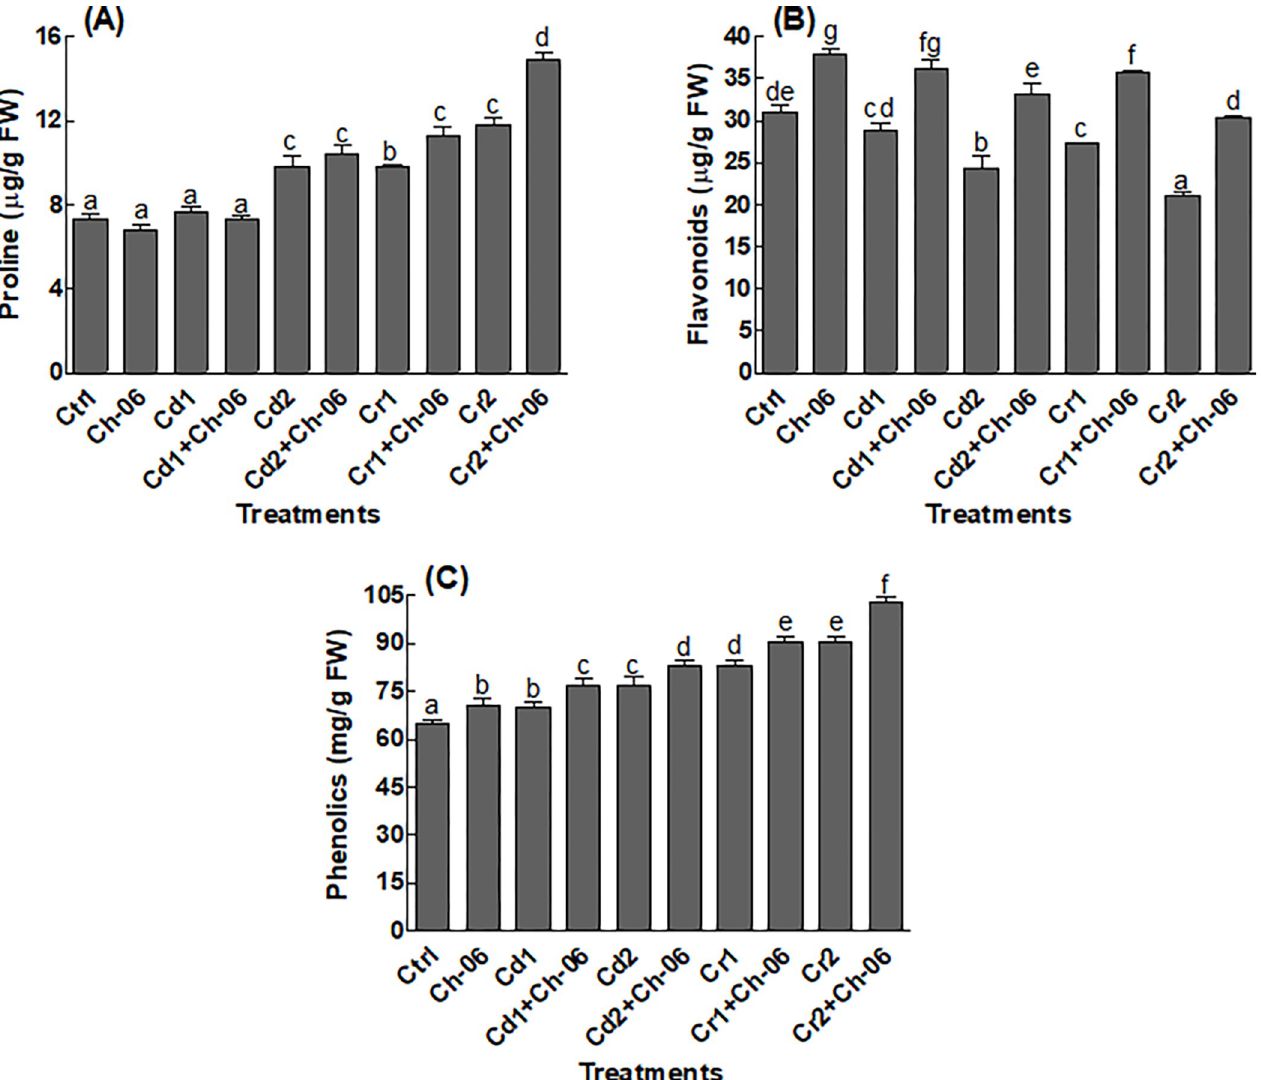
Fig 6. Impact of Ch-06 ( A . violaceofuscus ) on IAA content of okra under elevated Cd and Cr stress. Co: Control, Cd = cadmium, Cr = chromium, Cd1 and Cr1 = 100 μ g/g, Cd2 and Cr2 = 500 μ g/g. The data reflect the mean of triplicated data followed by ± SE. The data with different superscript letter are significantly different at P =